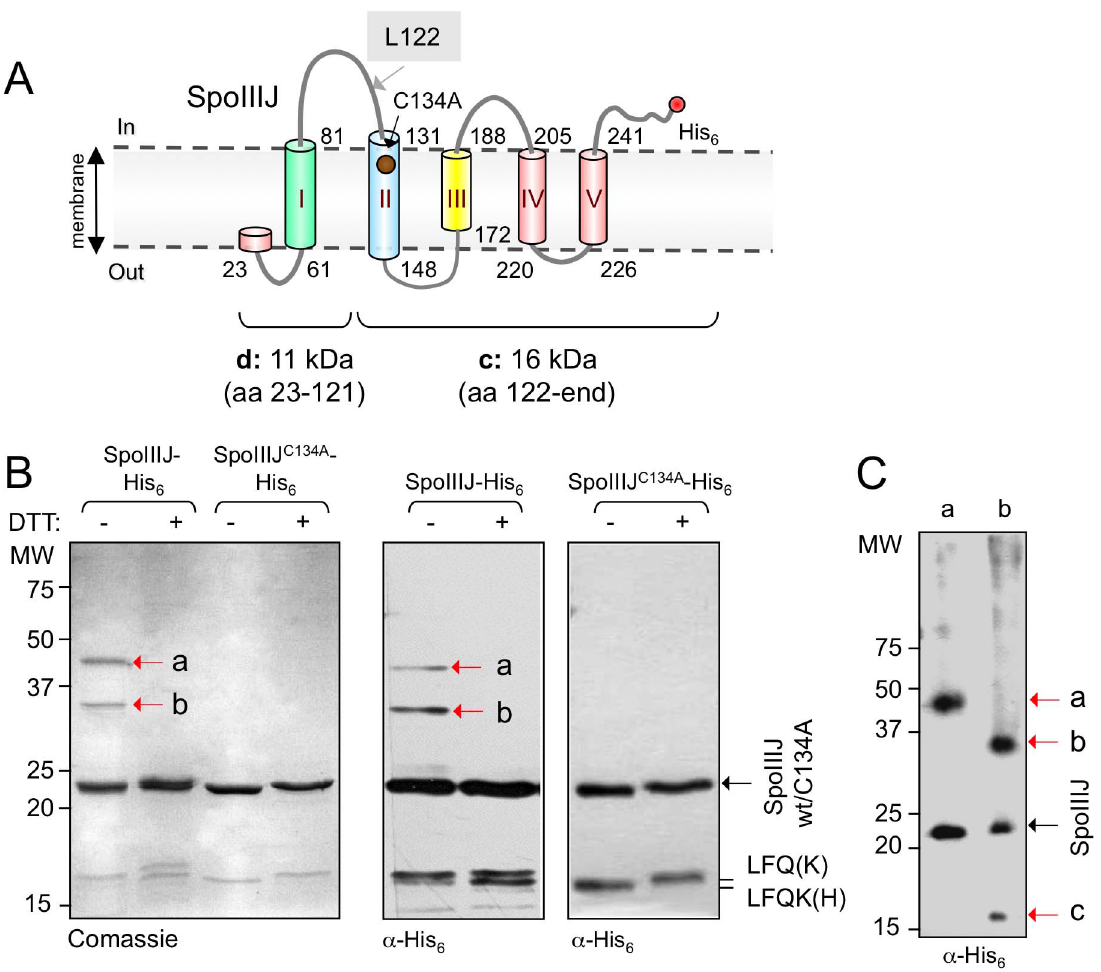
Figure 1. Dimerisation of SpoIIIJ-His 6 purified from E.coli . (A) Topological model of SpoIIIJ in the membrane. The numbers refer to the amino acid residues that delimit the transmembrane (TM) segments, depicted as cylinders. Cys23, in the signal peptide is indicated, as well as Cys134 in TM2 (red circle). (B) SDS-PAGE and Coomassie-staining (left panel) or immunoblotting (right) with an anti-His 6 antibody of purified SpoIIIJ-His 6 and SpoIIIJ C134A -His 6 in loading buffer with (100 mM) or without DTT. The N-terminal sequence of two processing products of SpoIIIJ-His 6 is indicated. (C) Immunoblot analysis of SpoIIIJ-His 6 species ‘‘a’’ and ‘‘b’’, isolated from the gel in panel B (left), using an anti-His 6 antibody. In panels B–C, the position of molecular weight markers (in kDa) is shown; black arrows show the position of full-length SpoIIIJ-His 6 and red arrows the position of other SpoIIIJ forms.